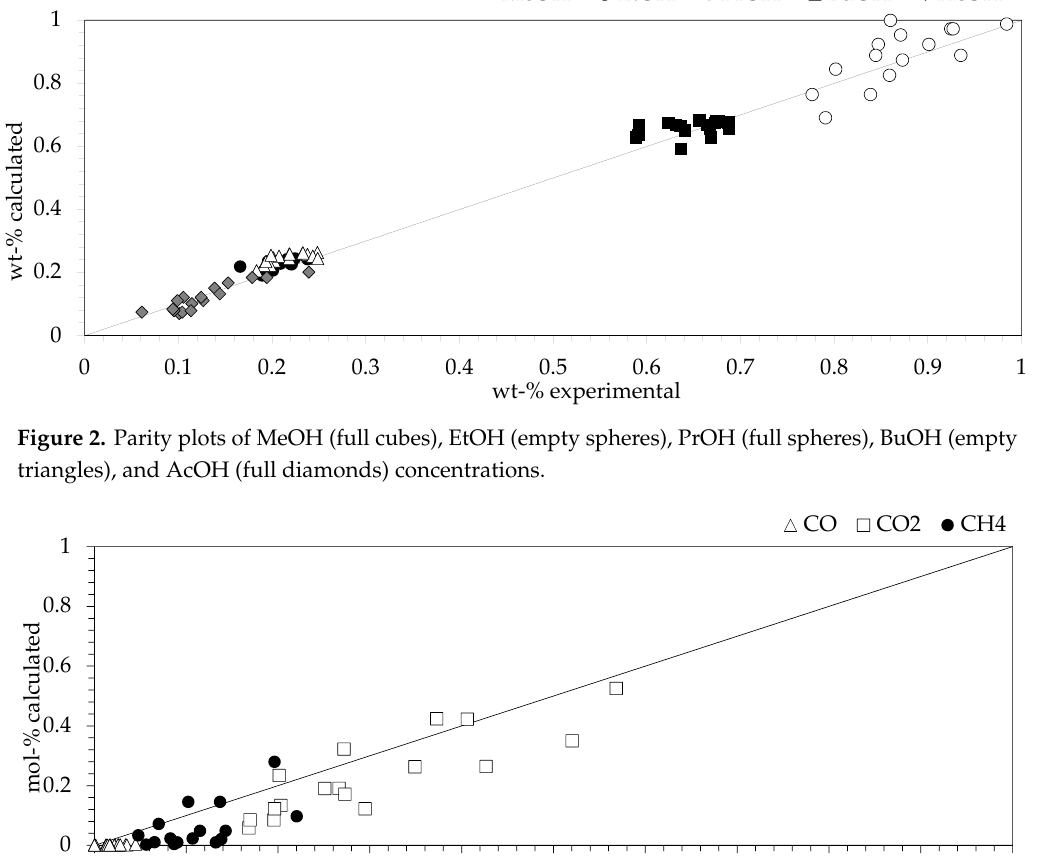
Figure 4. Experimental (empty symbols) and calculated (connected full symbols) weight concentrations of MeOH (diamond), EtOH (cube), PrOH (sphere), BuOH (triangle) and AcOH (cross) at 230 °C, 3.2 MPa and different reactor space-times.